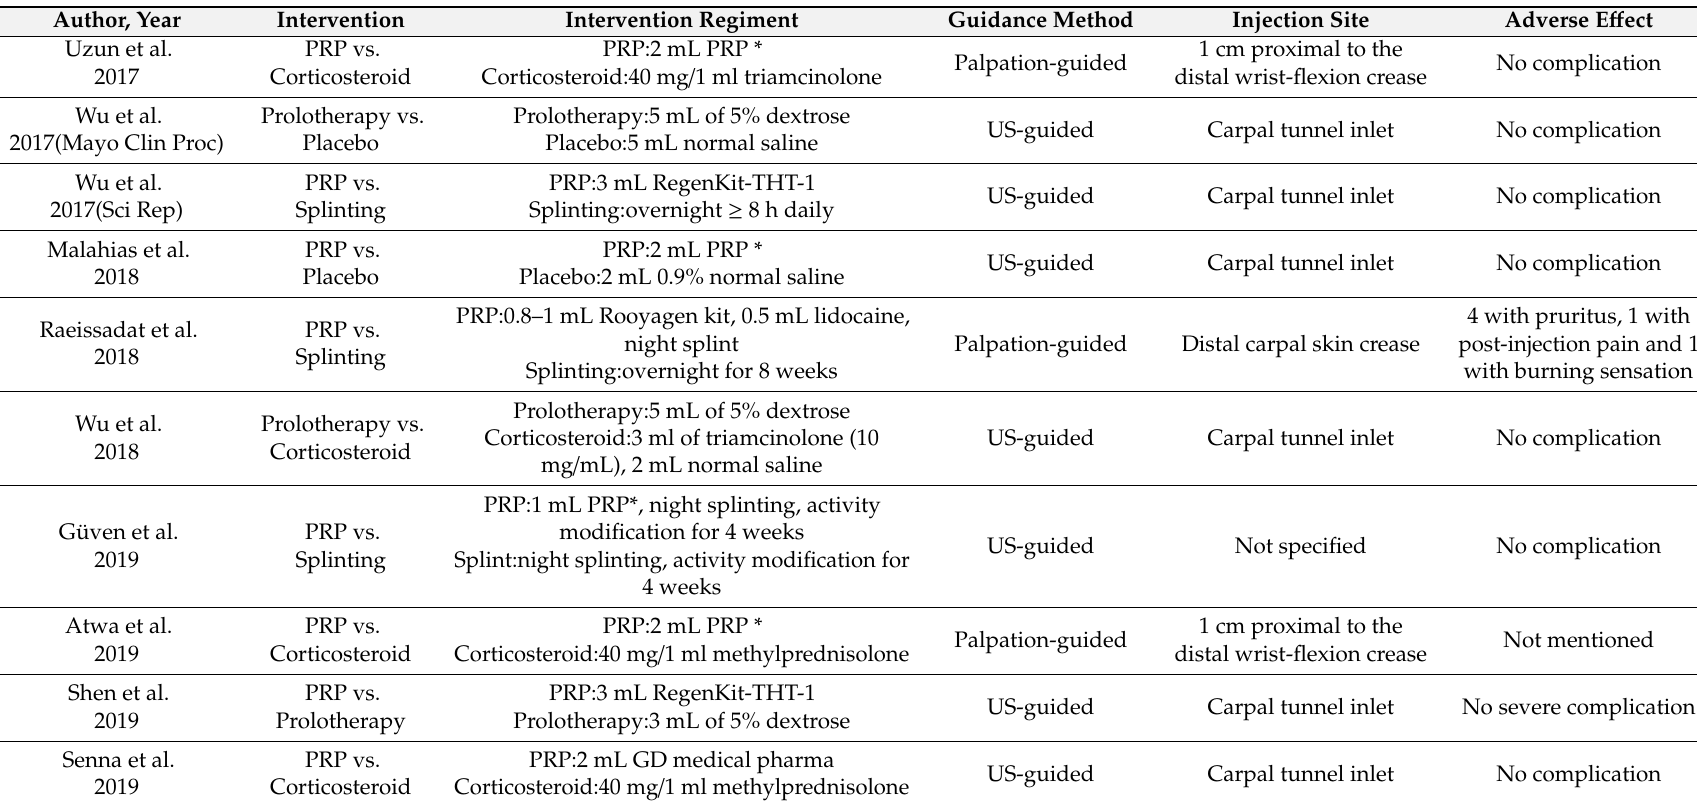
Table 2. Summary: the intervention details of included studies using regenerative injection (comprising 5% dextrose and platelet rich plasma) for treating carpal tunnel